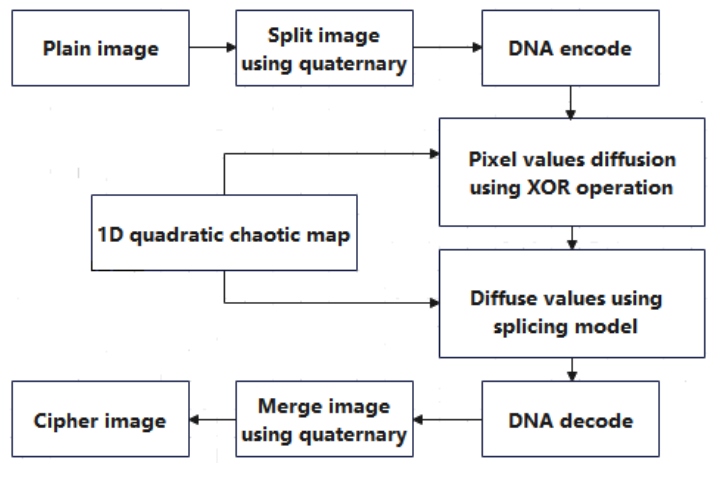
Figure 3. Encryption Process.